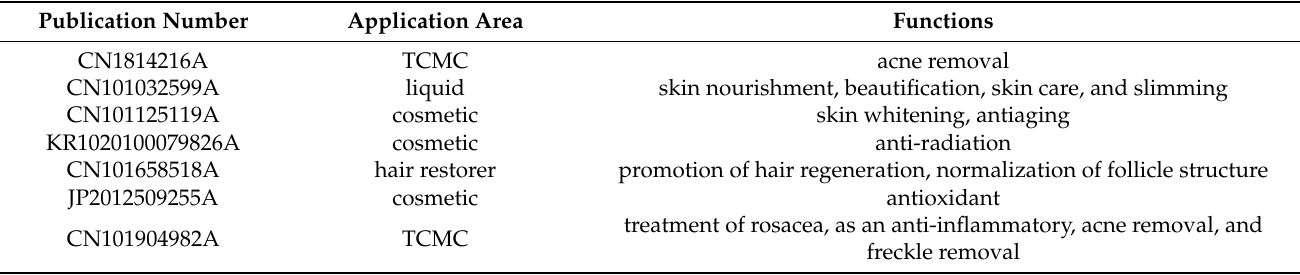
Table 2. Applications and main functions of the granted lily-related cosmetic